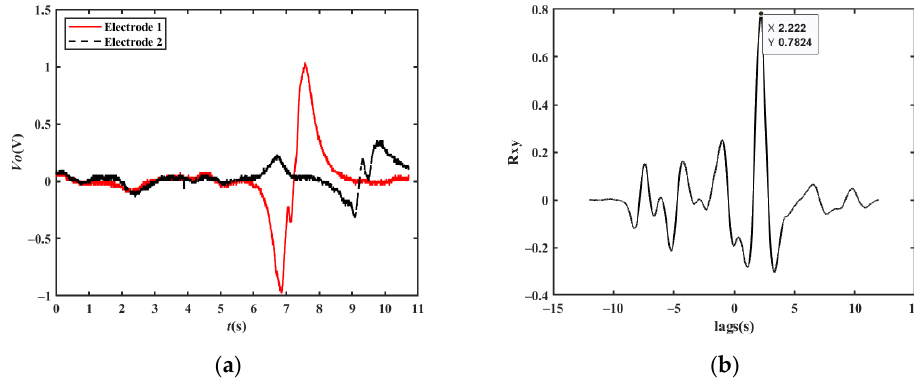
Figure 21. Experimental results of a single vehicle changing lanes at 25 km/h: ( a ) original waveforms at a velocity of 25 km/h while changing lanes; ( b ) cross-correlation results at a velocity of 25 km/h while changing lanes.